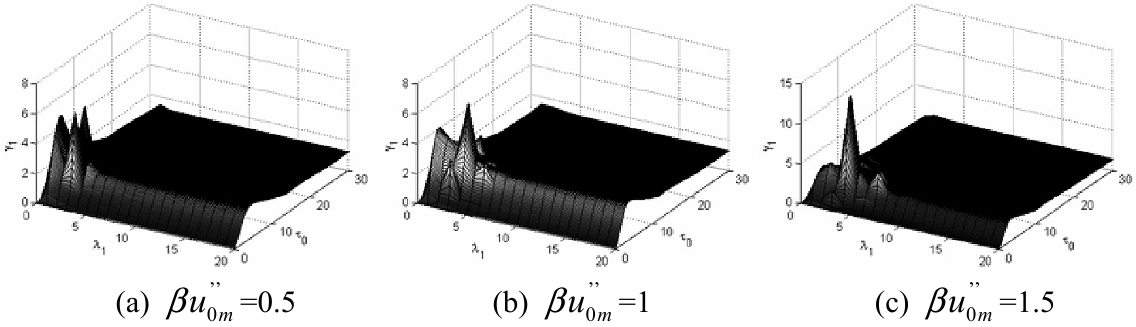
(cid:1)(cid:1) λ 2 = 0 . 1 , ζ 1 = 0 , ζ 2 = 0 . 0 m ). Here,